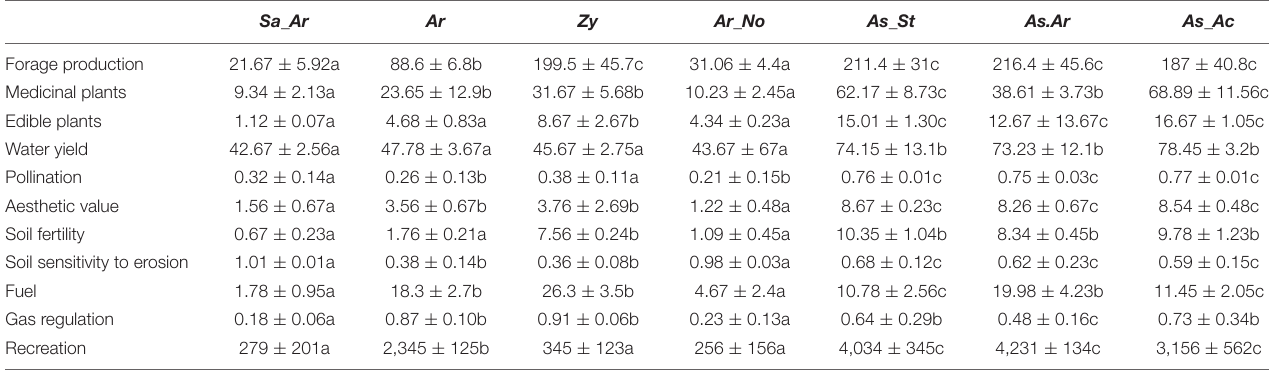
TABLE 2 | Potential of different plant communities in providing ecosystem services. Sa_Ar Ar Zy Ar_No As_St As.Ar As_Ac